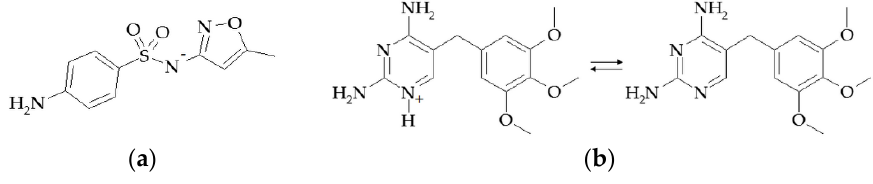
Figure 1. The structure of SMX − ( a ) and TMP + /TMP ( b ). Calibration solutions of SMX and TMP with various concentration ratios ranging from 6.0 × 10 − 6 to 6.0 × 10 − 5 M were prepared for spectrophotometric analysis. An ammonium buffer solution (pH 10.0) was used to set the pH of the solutions.